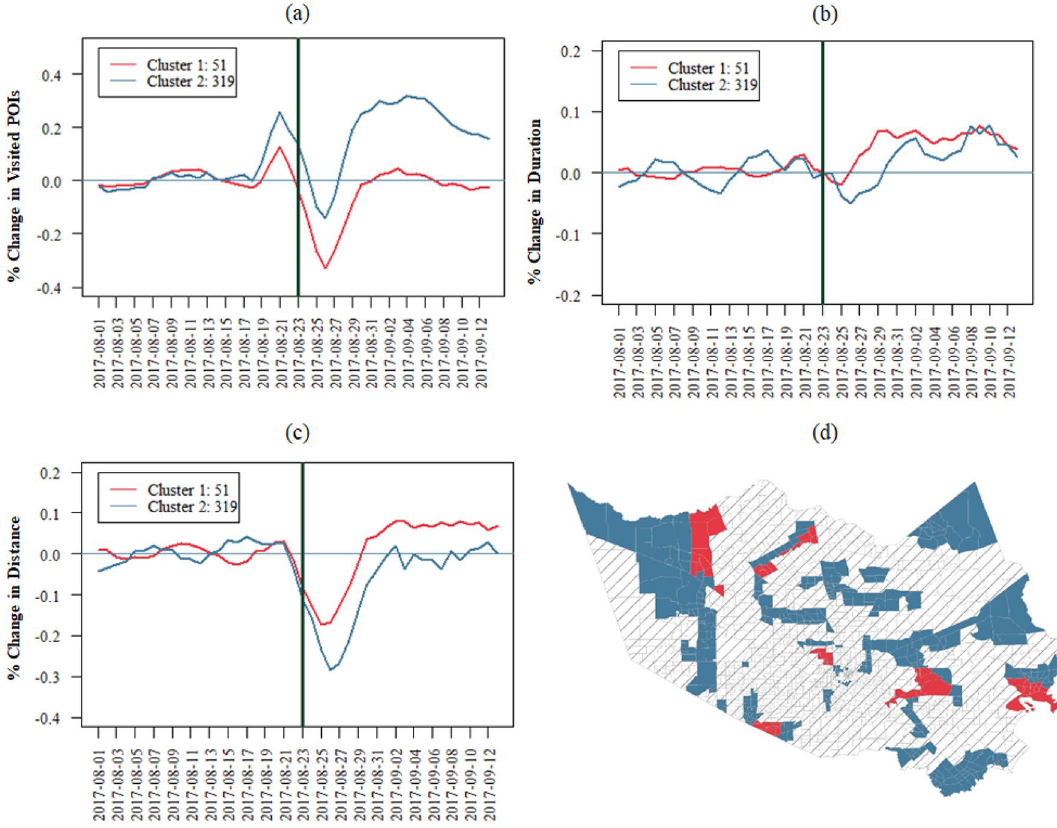
Figure 6. Clusters of access to grocery stores by considering the three access indicators. These clusters include areas affected by flooding: ( a–c ) time-series level of the identified clusters for the access indicators; ( d ) maps of the clusters; ( a ) daily pattern of impact and short-term recovery for the visited POIs, which shows the patterns of the change in the redundancy access dimension compared with the baseline. In ( b ) and ( c ) show that as duration and distance increase, rapidity and proximity decrease. The cluster identified as blue shows an increased level in visited POIs, while the distance and duration for this cluster show a better access pattern compared with the red